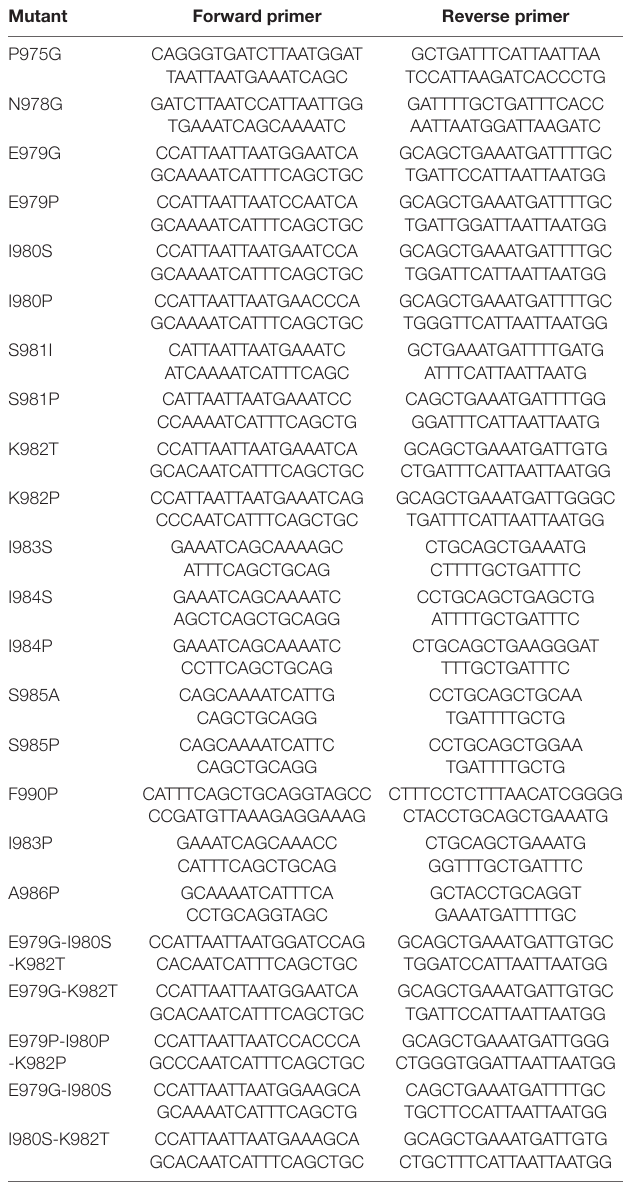
TABLE 1 | Primers used for quick-change polymerase chain reaction. Mutant Forward primer Reverse